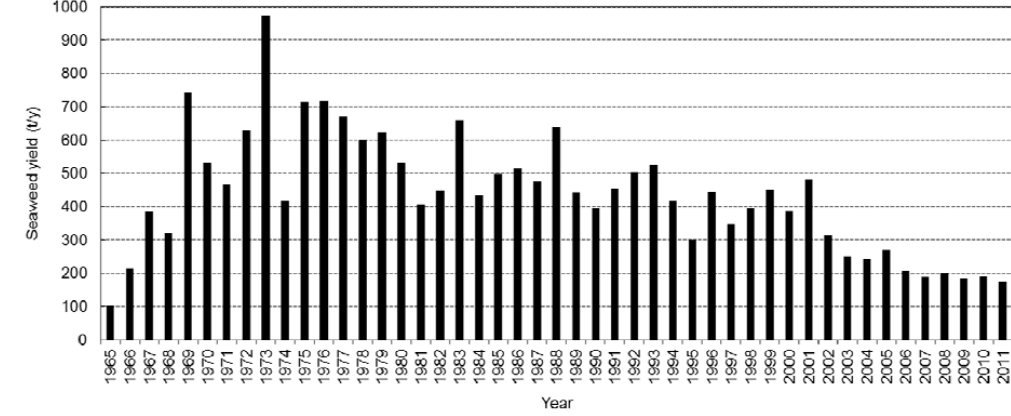
Figure 2. Variation in annual yield of seaweed in the coastal area of Saijo city from